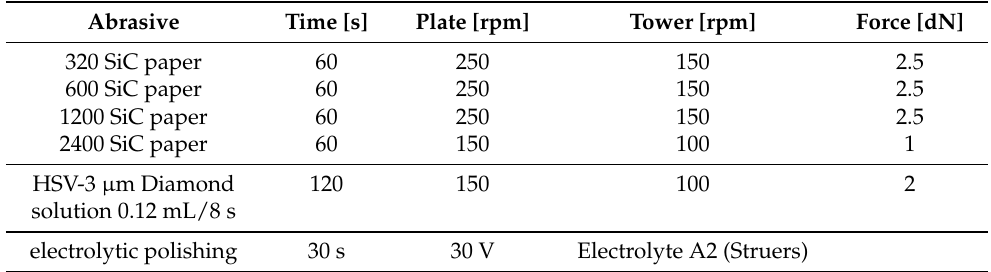
Table 2. Polishing procedure applied to the 316L stainless steel samples. Plate and tower rate are the parameter of the used automatic